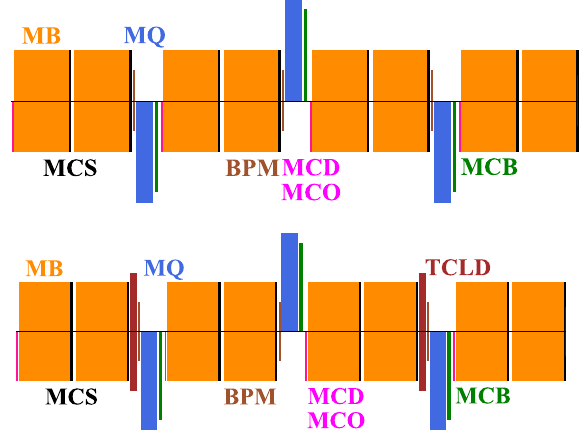
FIG. 15. Irregular part of the dispersion suppressor, right of the interaction region, consisting of eight main dipoles (MBs), each equipped with a sextupole spool piece corrector (MCS), three quadrupoles (MQ), three orbit correctors (MCB), three octupole (MCO) and decapole correctors (MCD) and three beam position monitors (BPMs), without (top) and with (bottom) collimators